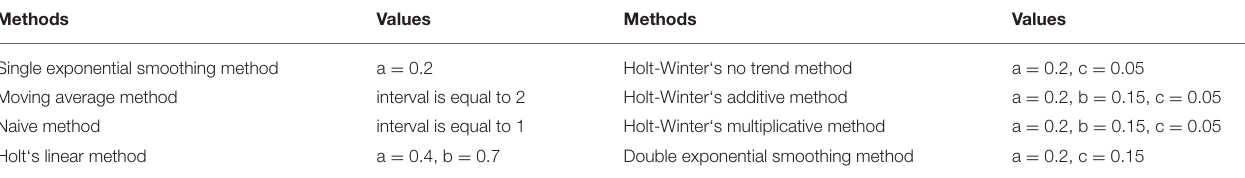
TABLE 3 | The values in components.